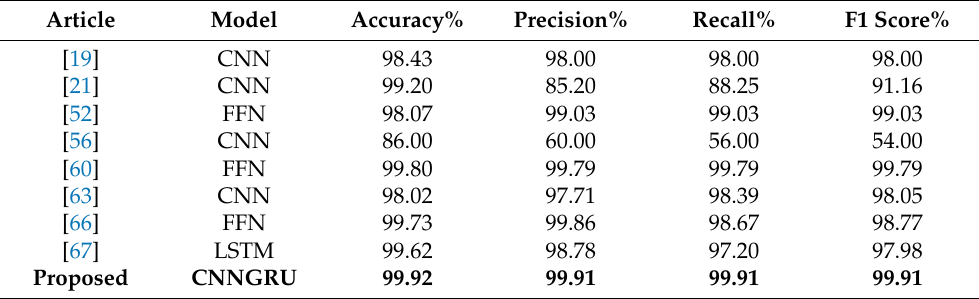
Table 14. Multiclass classification